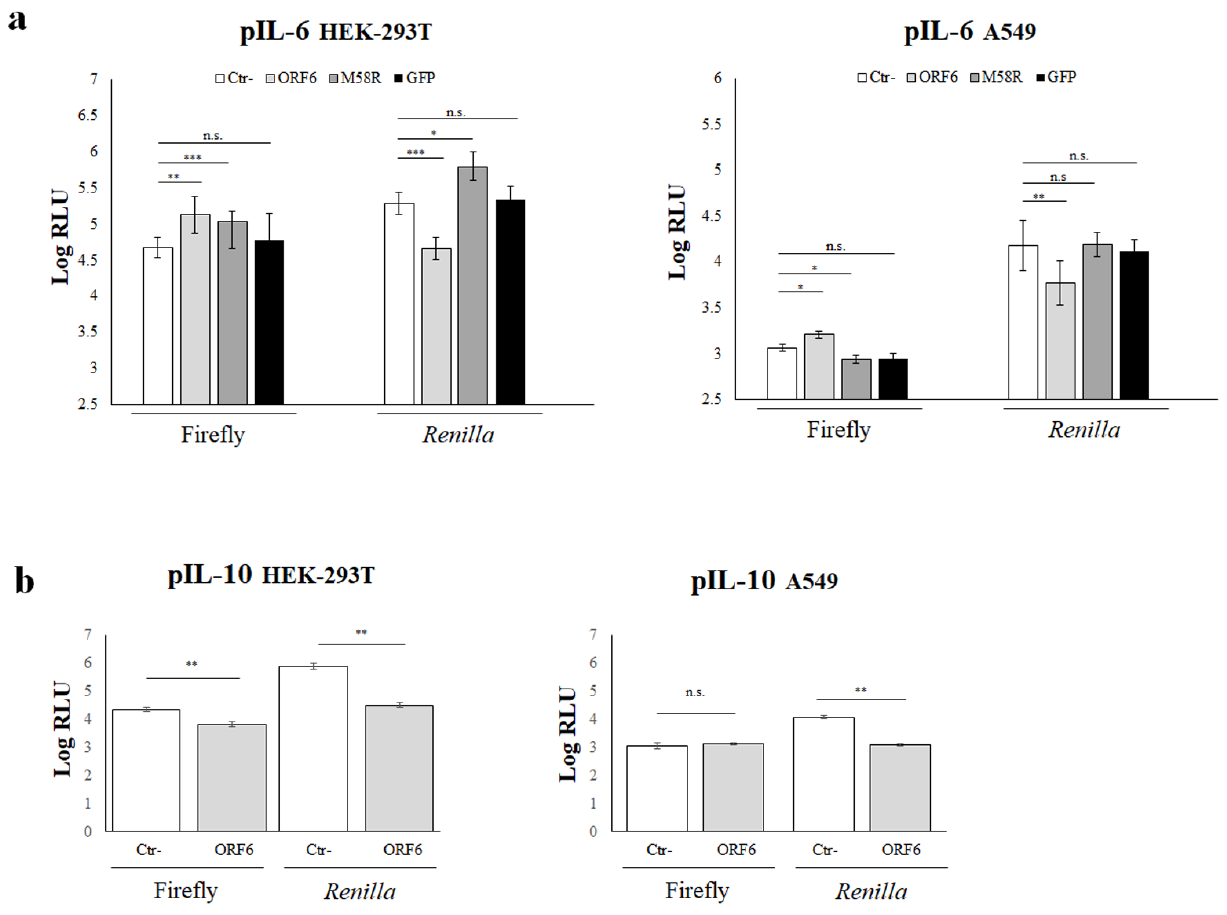
Figure 2. IL-6 and IL-10 promoter activation is deregulated by ORF6 protein. ( a ) HEK-293T (left panel) or A549 (right panel) cells were co-transfected with the interleukin-6 promoter-mediated firefly luciferase (pIL-6), along with the SV40 promoter-mediated Renilla luciferase reporter plasmids. Where indicated, ORF6, M58R mutant, or green-fluorescent protein (GFP) protein expression was achieved by transfection. Negative control (Ctr-) samples were transfected with empty plasmid along with reporter plasmids. At 48 h post transfection, firefly and Renilla luciferase activities were measured and compared to the relative control sample (Ctr-). Three ( n = 3) independent experiments were performed and representative data are presented as mean logarithm values of relative lumi- nescence unit (RLU) ± standard deviations. ( b ) The influence of ORF6 protein on pIL-10 activation was evaluated in both HEK-293T (left panel) and A549 (right panel) cells. Means of relative lumi- nescence unit (RLU) logarithm values ± standard deviations are presented. ( a,b ) Significance was evaluated as p < 0.05 (*** p < 0.0005, ** p < 0.005, * p < 0.05, n.s. not significant). The expression of the irrelevant GFP protein did not show any effect on pIL-6 pro- moter activation (Figure 2a), thus we concluded that the stimulatory function of the ORF6 is a peculiarity of the viral protein. On the contrary, the viral accessory protein wt-ORF6 retained its antagonistic function on pIL-10, with a 1.2-fold downregulation of its activity ( p = 0.0016, **) (Figure 2b, left panel). Since HEK-293T cells do not represent the elective host for studying respiratory viruses, the pIL-6 and pIL-10 activation was further exam- ined in another cell type. The human alveolar basal epithelial cells A549 were co-trans- fected with the pIL-6 or pIL-10-luciferase reporter, pSV40-RL internal control, and— where indicated—the ORF6 viral genes, empty vector, or GFP-expressing plasmid. At 48 h post-transfection, the reporter expression was examined. The new results matched with those obtained in HEK-293T cells, with a 1.4-fold stimulation on pIL-6 ( p = 0.01, *) but not on pIL-10 ( p = n.s.) by the wt-ORF6 (Figure 2a,b, right panels). The ORF6 M58R mutant